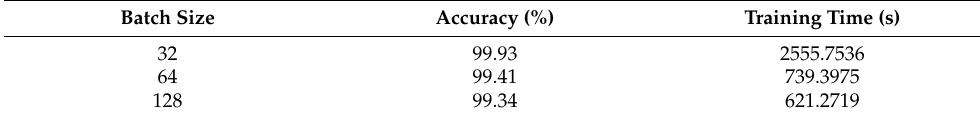
Table 2. Accuracy at different batch sizes B [ I = 64 × 64, R = 0.0001, θ = Adam].